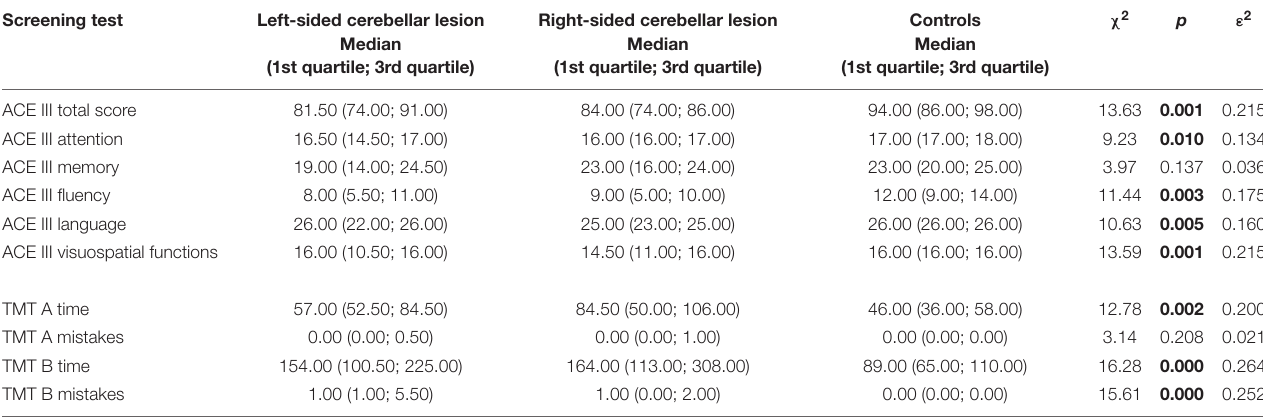
TABLE 2 | Comparison in screening test scores between patients with left-sided cerebellar lesions, patients with right-sided cerebellar lesions and controls (Kruskal–Wallis test). Screening